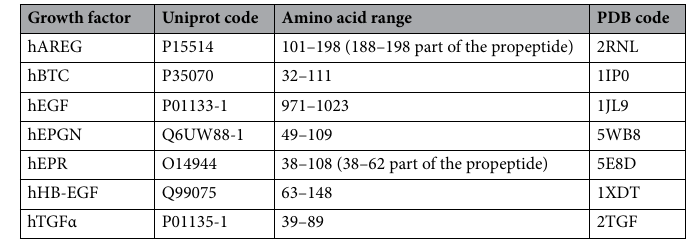
Table 1. Sequences of the growth factors used in this